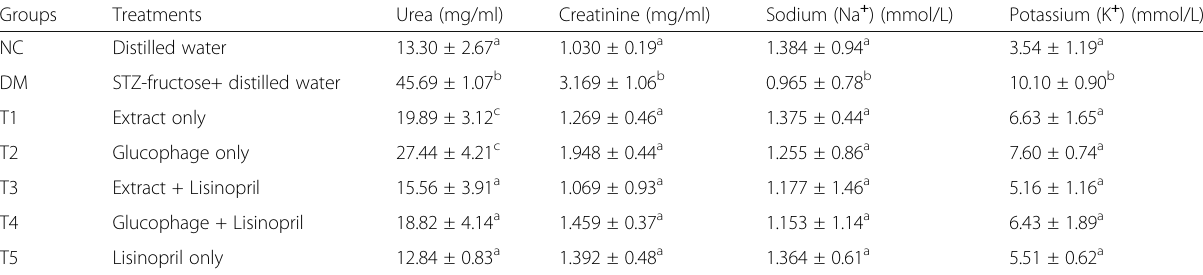
Table 3 Effect of combined administration of lisinopril and ethanolic bark extract of E. chlorantha on serum urea, creatinine, Na + and K + level in type 2 diabetes rats